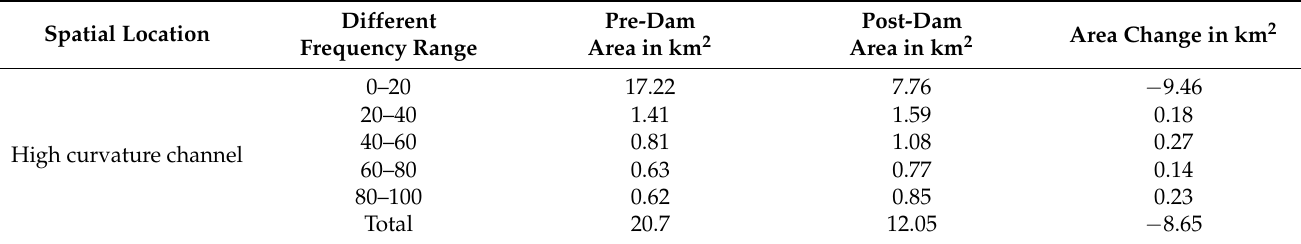
Figure 8. Post-dam differences the submerged state between the highly curved river segment and the straight river segment. Table 5. Typical regional variation area difference in